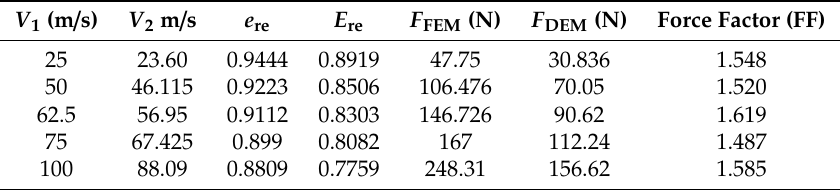
Table 3. Elastic run for Shot 0.3556 mm.